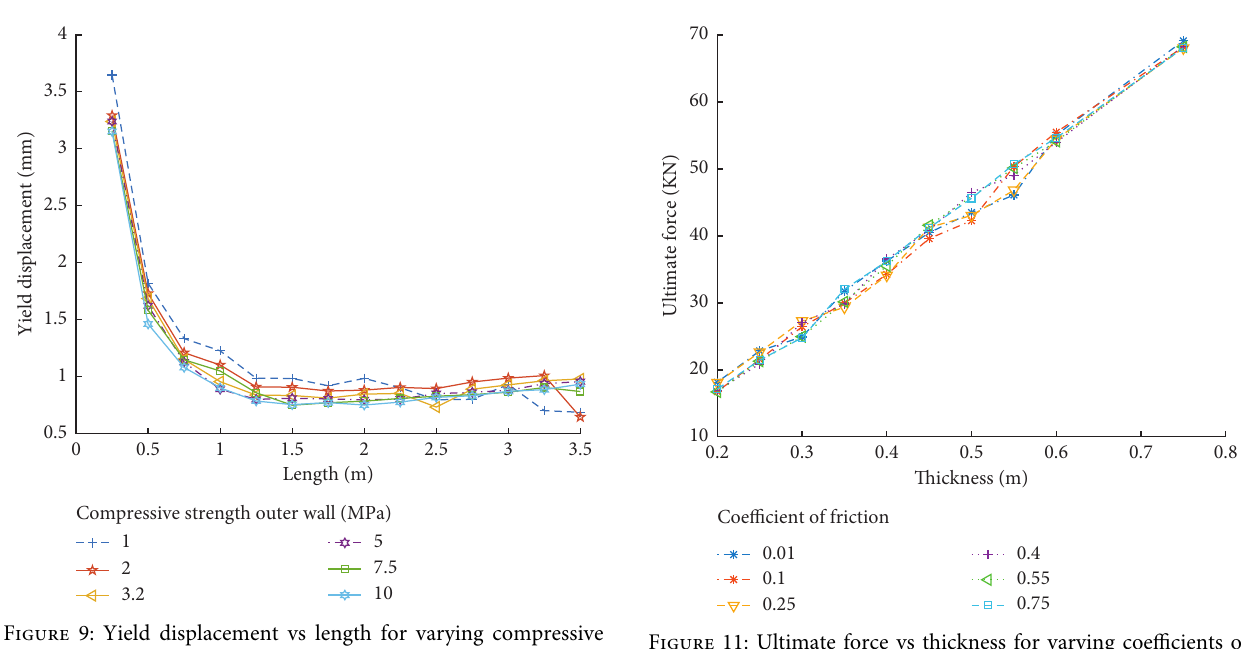
Figure 11: Ultimate force vs thickness for varying coefficients of friction.